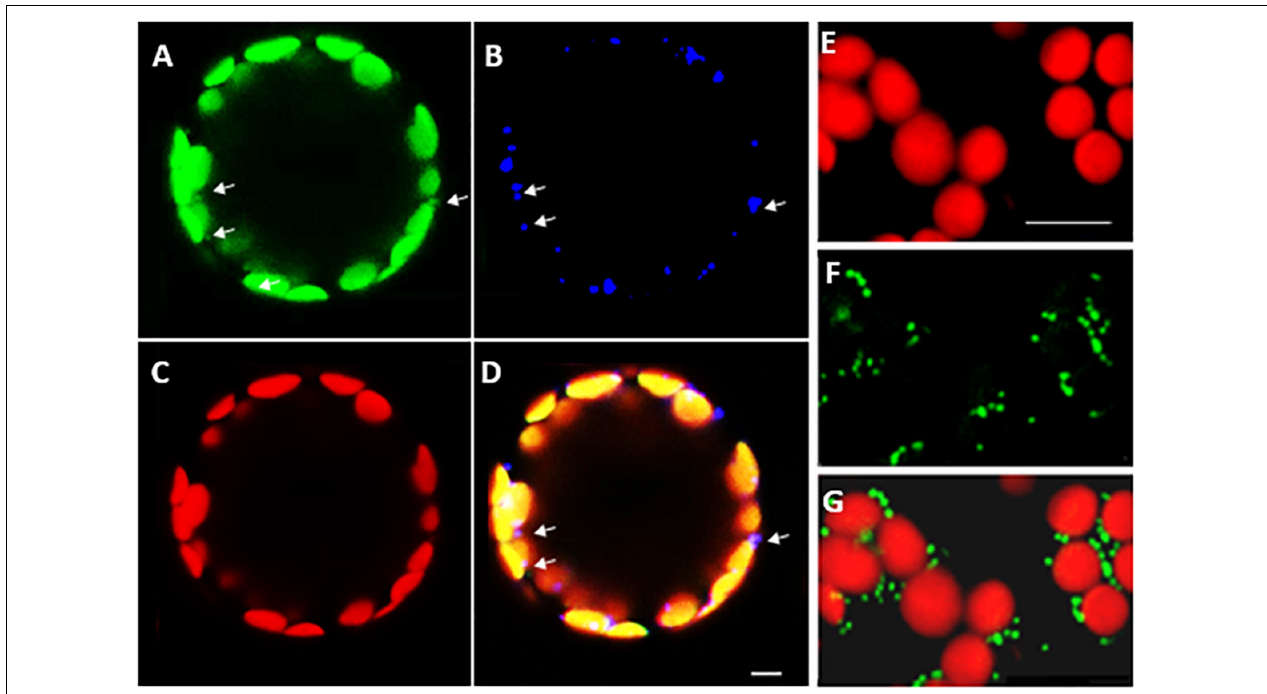
FIGURE 2 | Intracellular localization of LEA5 in mesophyll protoplasts and mesophyll tissue of Arabidopsis leaves. Mesophyll protoplasts (A–D) and leaf mesophyll cells (E–G) taken from 5 days old Arabidopsi s seedlings (T 5 generation) expressing the LEA5-YFP protein. Green: YFP signal (A) , blue: MitoTracker Red CMXRos (B) , red: chlorophyll autofluorescence (C) and overlay (D) . The detection of the LEA5-YFP protein in the mitochondria of the mesophyll cells of 5-day old leaves of Arabidopsis seedlings (F,G) . Arrows indicate mitochondria. Scale bar = 10 µ